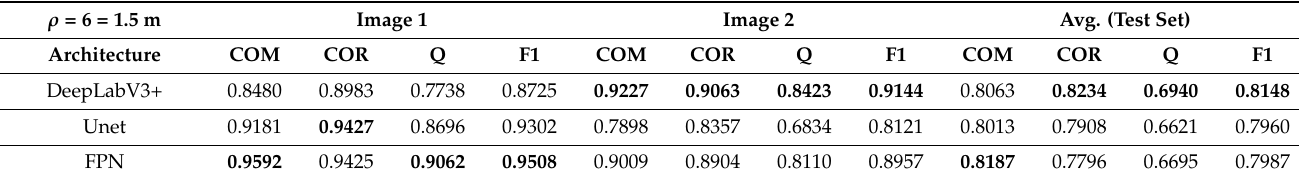
Table 4. Rural road extraction quantitative results for a ρ = 6 (using the Zhang–Suen thinning algorithm)—values in bold represent the road detection algorithm with the best performance in each parameter.